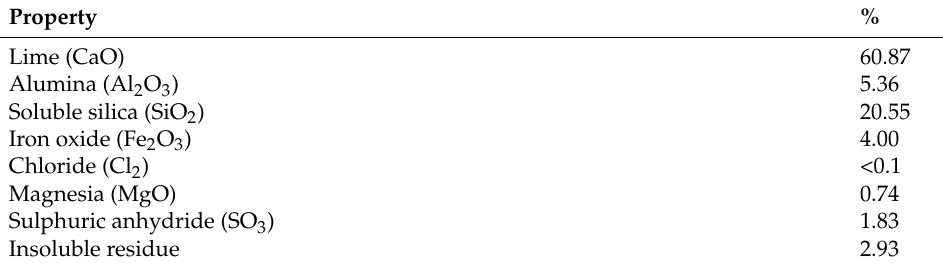
Table 1. Chemical properties of cement used for this study [125].